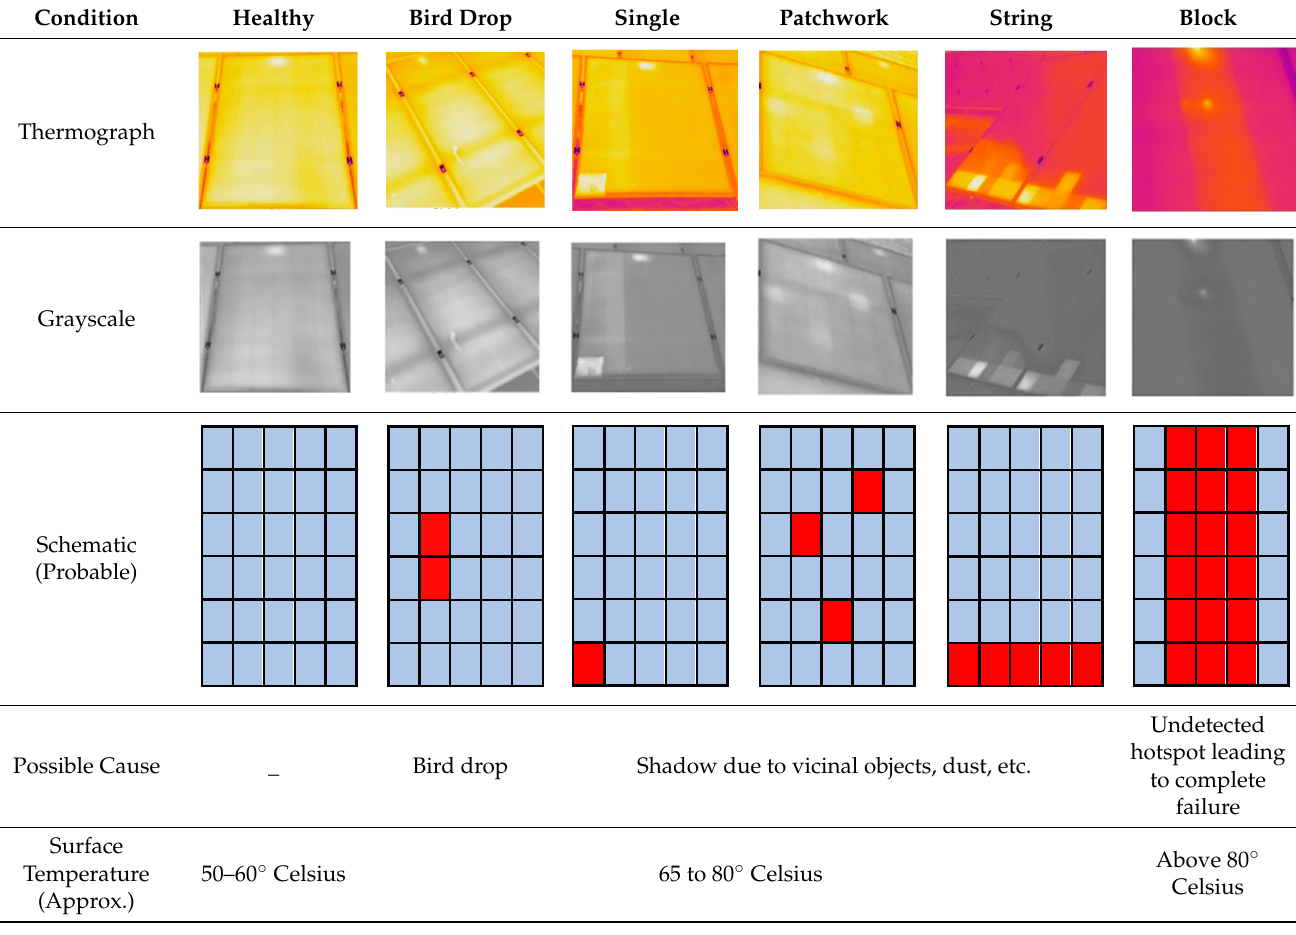
Table 1. Faults of PV panels.